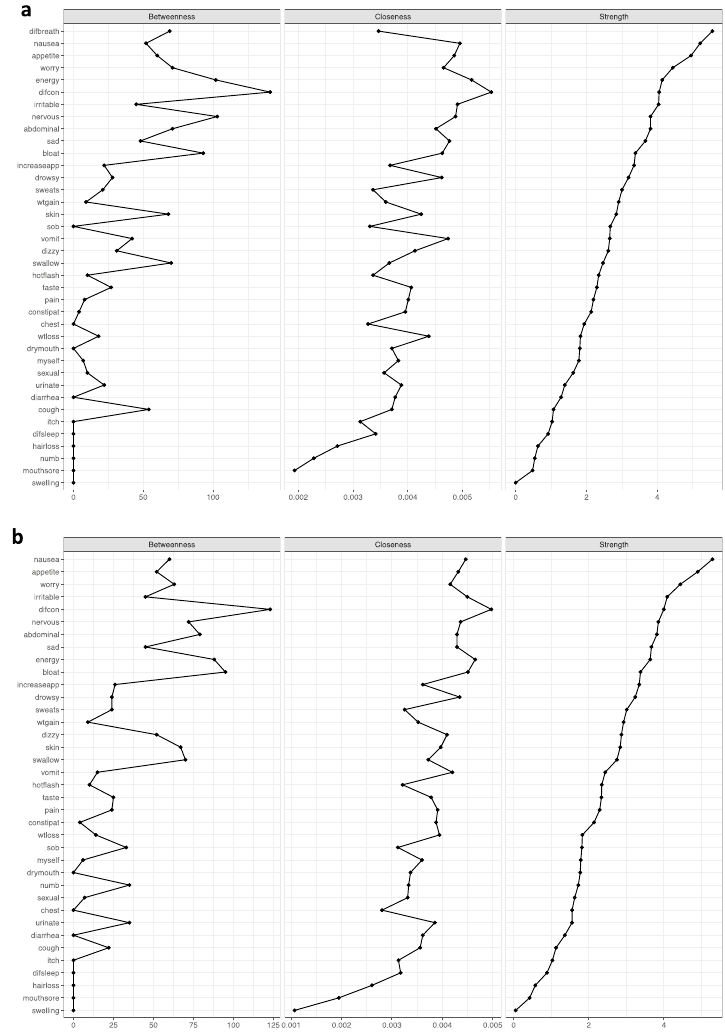
Figure 4. Comparison of centrality indices (betweenness, closeness, strength). Centrality indices ordered by strength values. Symptom(s) with no closeness coefficient appeared separated from the rest of the network. ( a ) Centrality indices (betweenness, closeness, and strength) for the estimated network shown in Fig. 1a. ( b ) Centrality indices (betweenness, closeness, and strength) for the estimated network at time-point 1 after removing difficulty breathing